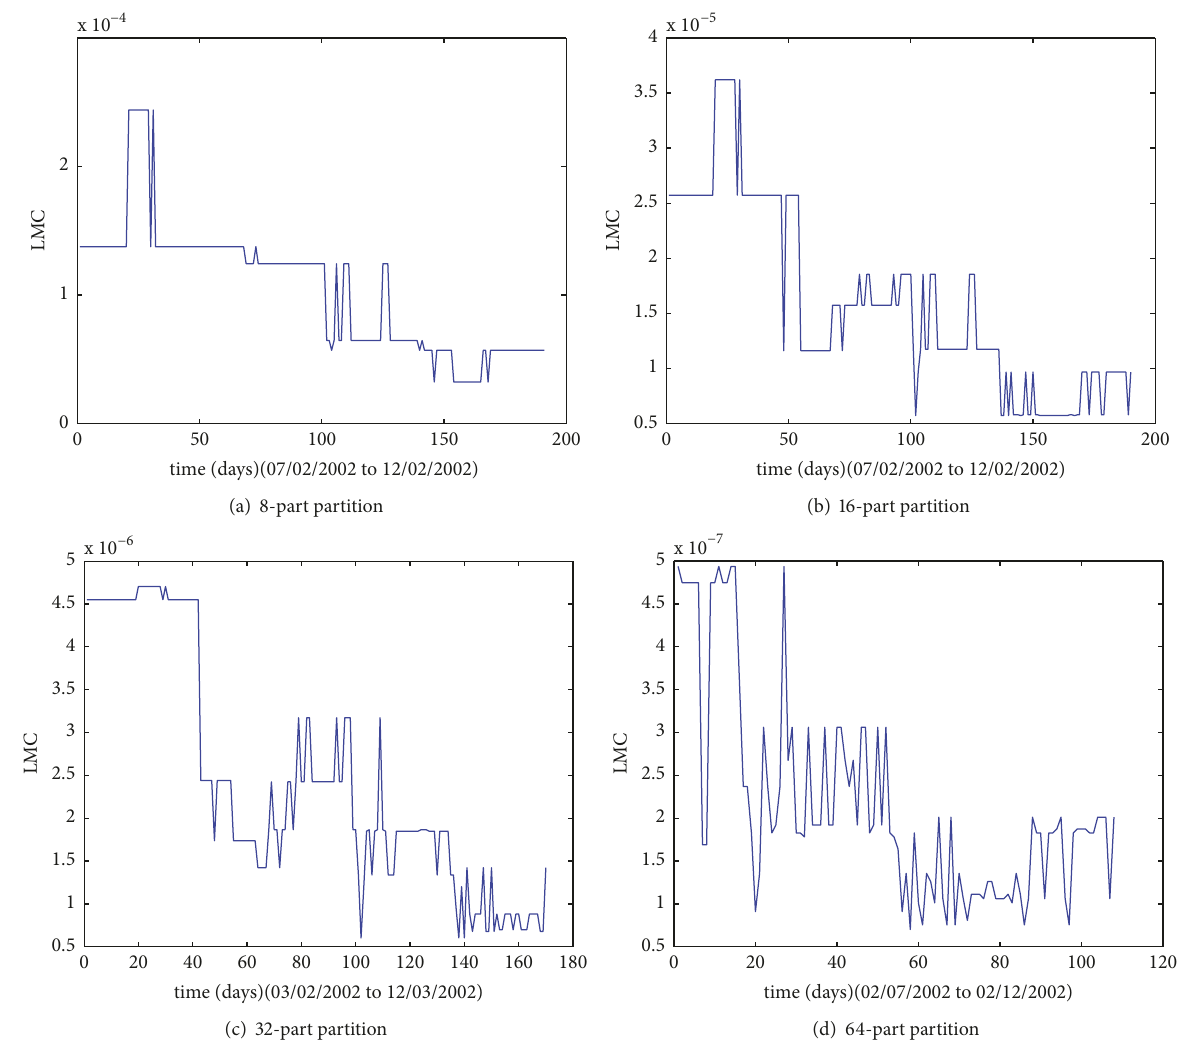
Figure 9: LMC temporal evolution for shorter time